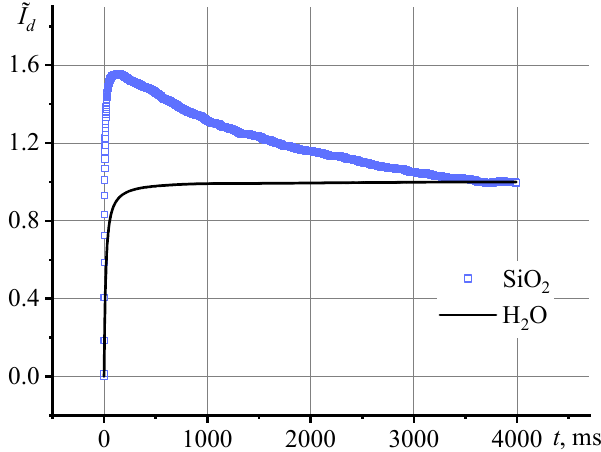
Figure 5. Transient curve for thermal lens dissipation, Equation (12), for a sample of Ludox (HS, d av = 12 nm) with a concentration of 22.4 mg/mL.